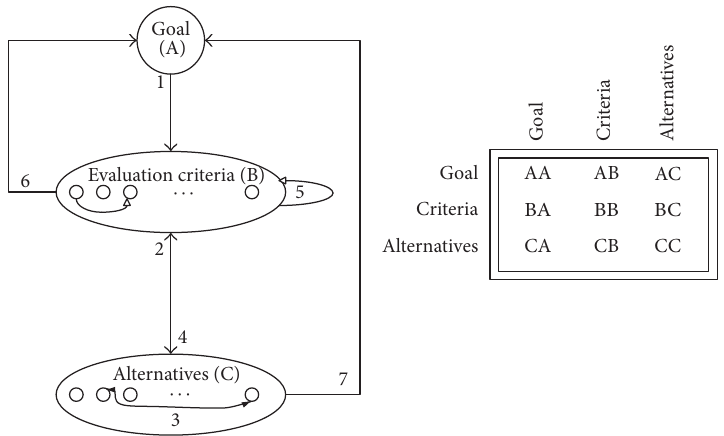
Figure 2: ANP structure and its corresponding unweighted supermatrix. Source: